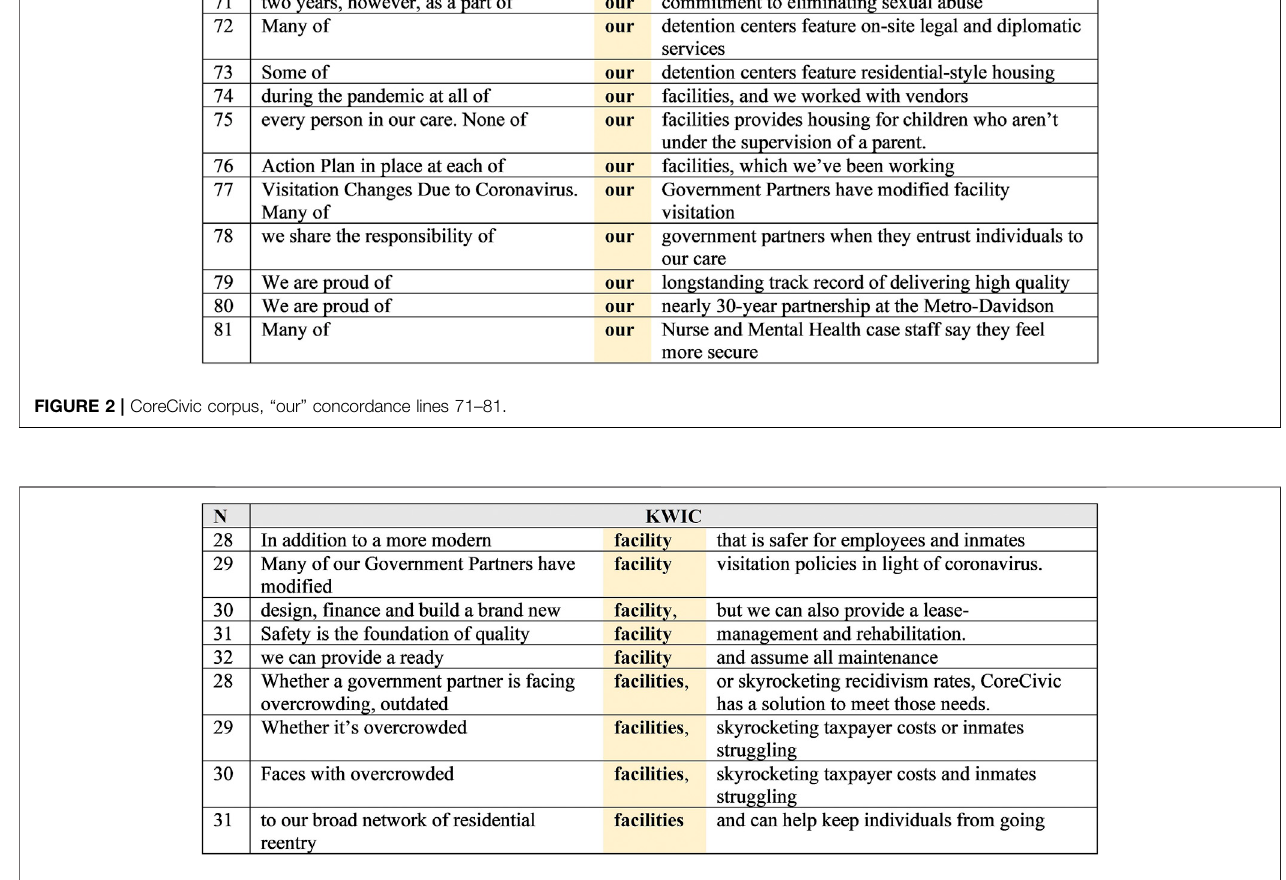
FIGURE 3 | CoreCivic corpus, “ facility ” and “ facilities ” concordance lines 28 – 32 and 28 – 31, respectively.